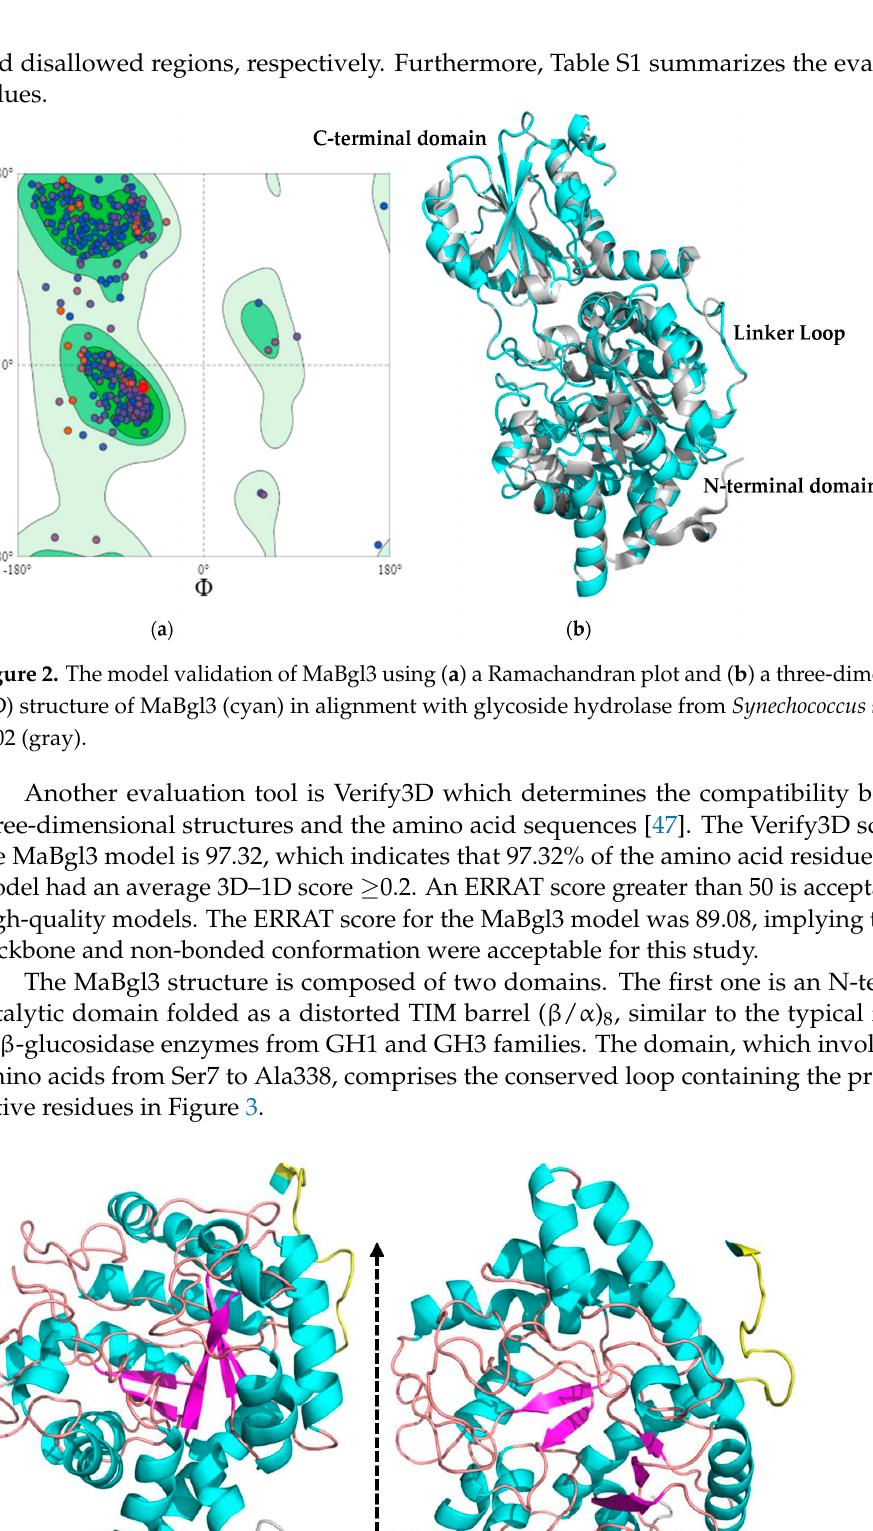
Figure 4. The C-terminal domain folded as a sandwich 3 α /6 β /3 α in two side views (cartoon structure: α -helices in cyan, β -sheets in magenta, and loops in beige) and linker loop in yellow in the MaBgl3 model. This folding of the C-terminal domain resembles the one found in studies of β -N- acetylglucosaminidases as a 3 α /6 β /3 α -fold type that is reasonably far from the catalytic site of the N-terminal domain [48]. The role of the C-terminal domain is not well established. However, it has been proposed that this domain is acting in the fixation of the substrate, in the correct position, to the active site, in adhesion of carbohydrates from the cell wall of microorganisms [49], and in recognition of substrates, whether this is the case of N-acetylglucosamine (GlcNAg) or specific substrates of β -glucosidases.